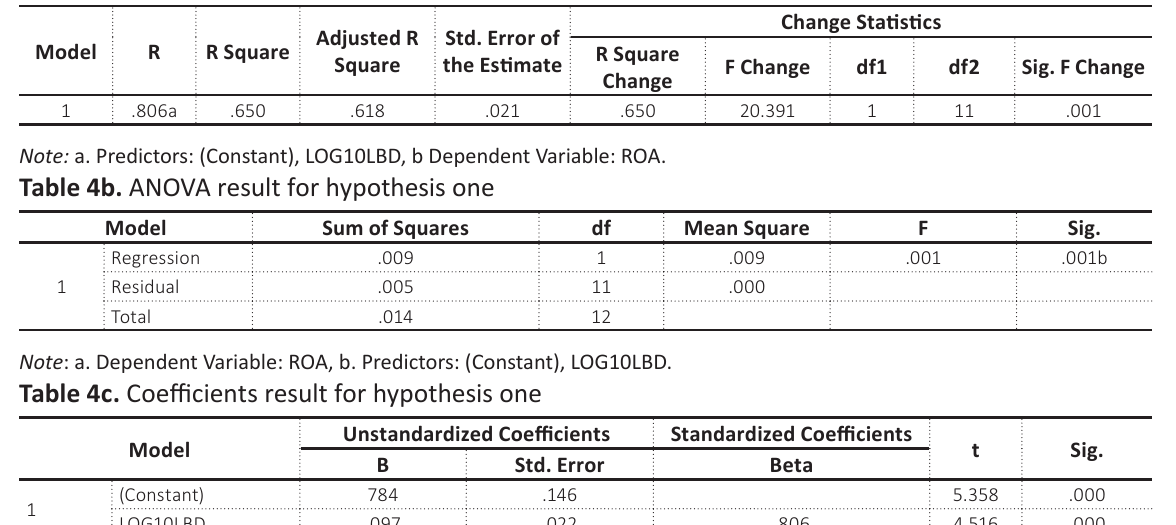
Table 4a. Model summary for hypothesis one